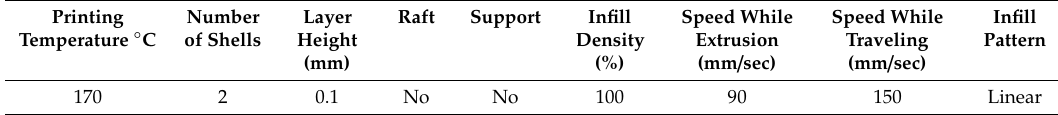
Table 2. Parameters used for the 3D printing of HPMC / glipizide